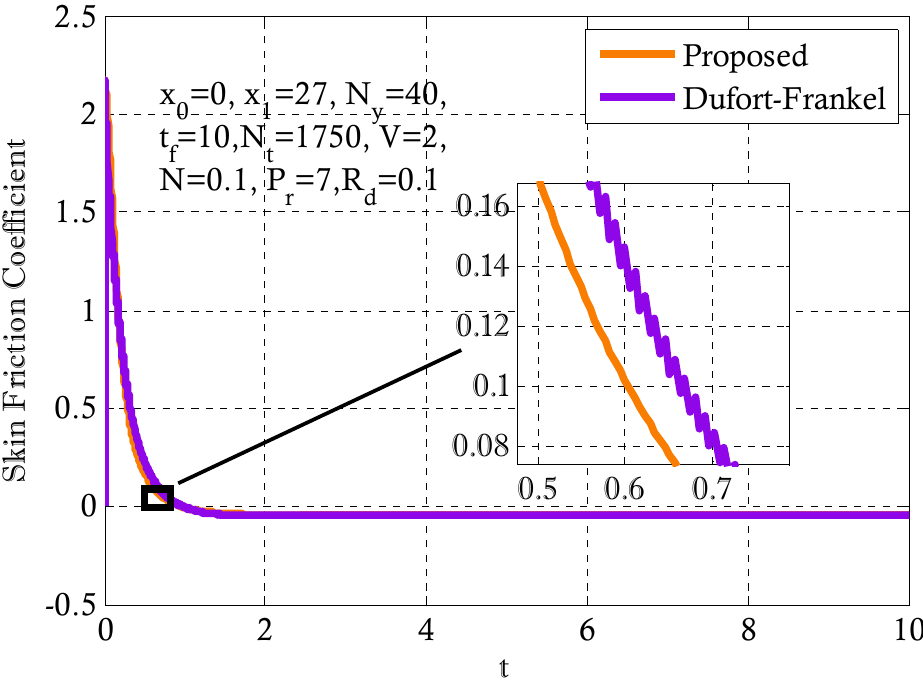
Figure 3. Comparison of the proposed scheme with the Dufort–Frankel method in finding the skin friction coefficient through time.